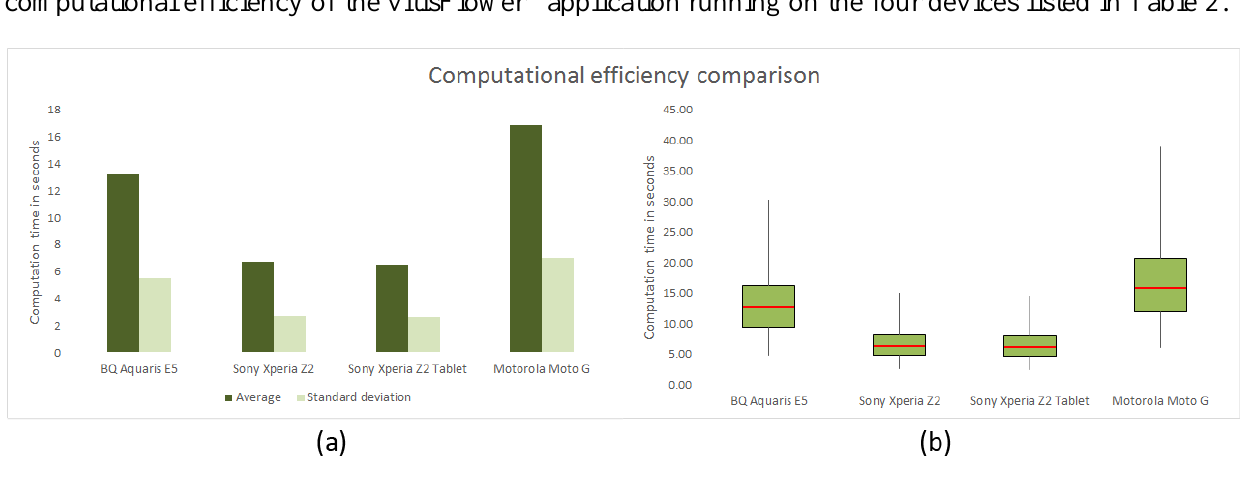
Figure 5. ( a ) Average and standard deviation of computation time for four different devices measured on the analysis of 50 images; ( b ) box and whisker plots for the same experiment shown in ( a